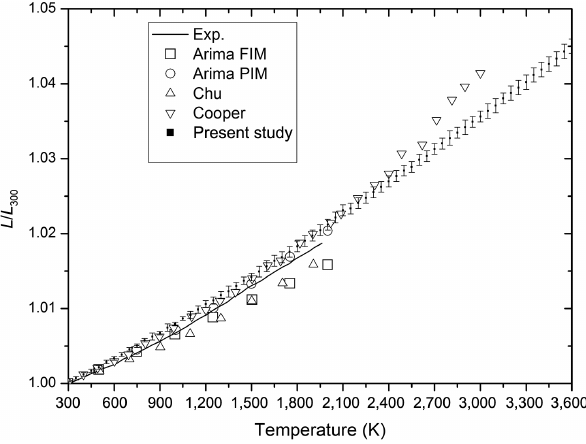
Figure 1: Lattice parameter evolution with temperature. Experimental data are from TPRC data series